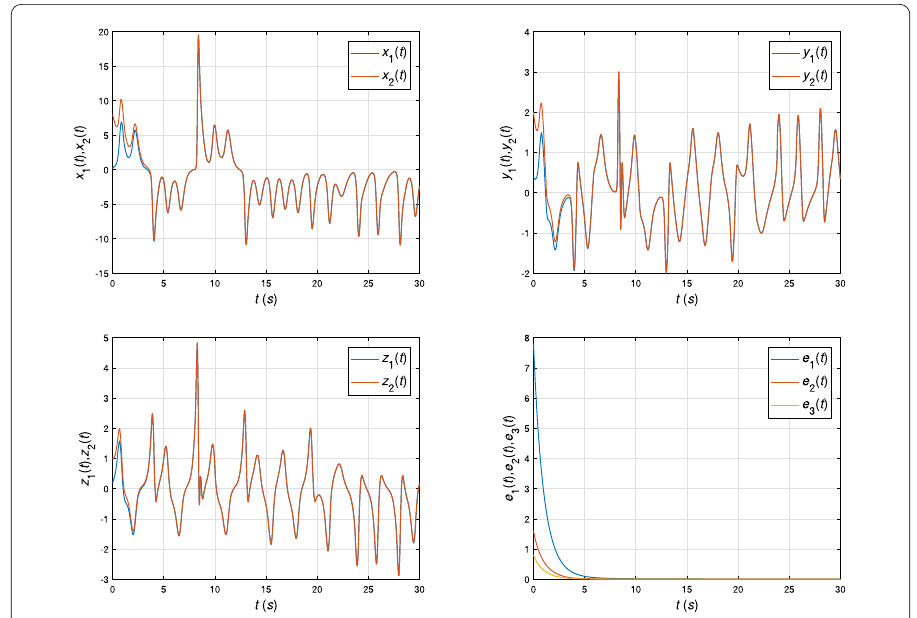
Figure 10 Synchronization results between two nonidentical fractional-order systems (37) and (38) for α 1 = α 2 = α 3 = 0.985